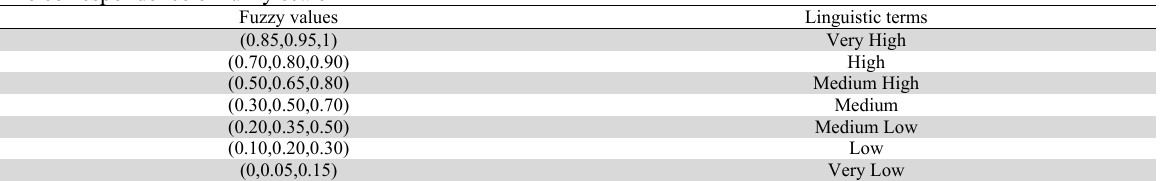
The correspondence of fuzzy